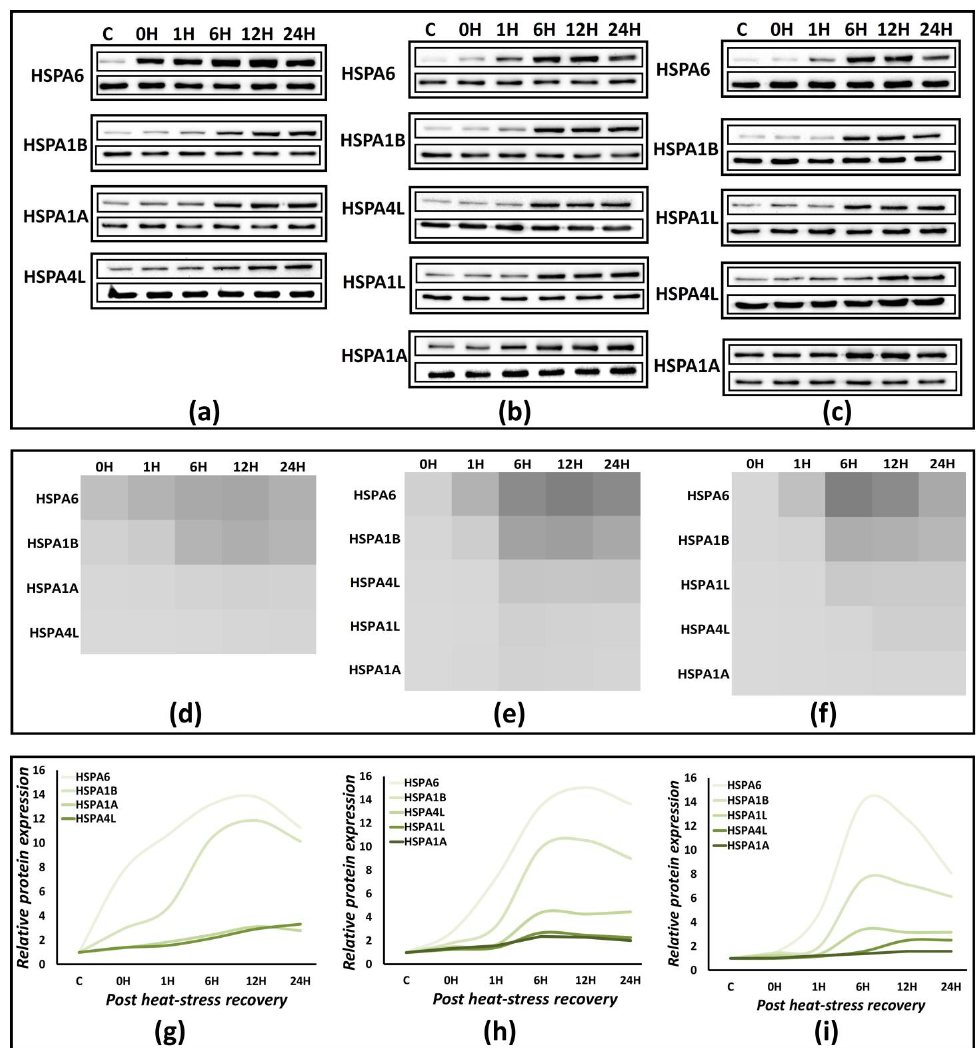
Figure 5. Protein profiling of the significantly expressing Hsp70s in Daoy ( a ), SH-SY5Y ( b ), and differentiated SH-SY5Y ( c ) cells. The lanes are in order Control, 0 H: immediately after heat stress, followed by periodic points during recovery at 37 °C at 1 h, 6 h, 12 h, and 24 h. Heatmaps ( d – f ) represent the relative expression of each protein with respect to the control (37 °C) expression nor- malized against GAPDH. They also highlight differential protein expression with respect to the other members. Smoothened scatterplots ( g – i ) trace the relative protein expression up to 24 h post heat stress and highlight the ‘ maximal protein expression ’ time point. (Figure S4: Bar graphs for quantification and statistical significance. Figure S5: Western blot quantification time plots and fold-change plots corresponding to scatter plots ( g – i